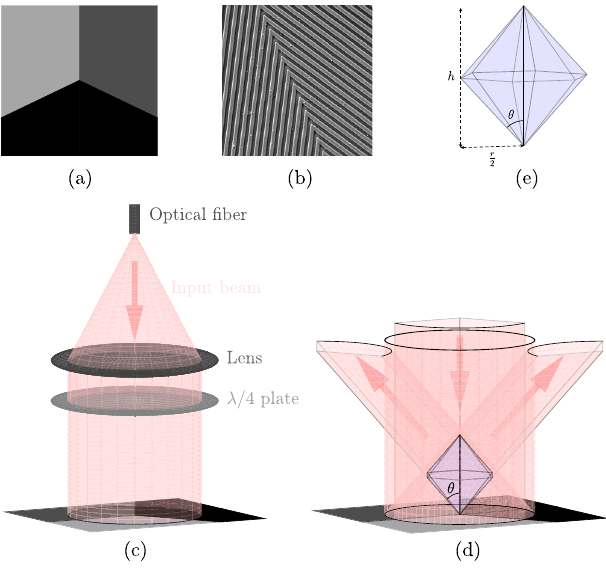
FIG. 1. Schematic representation of MOT production using an optical grating. (a) The grating chip consists of three identical linear gratings, lying in a plane with 120° relative orientations. (b) Scanning electron microscope (SEM) image showing the chip surface at a position where two gratings meet. (c) A single linearly polarized input beam emanating from an optical fiber is collimated and subsequently made circularly polarized. (d) The incoming and diffracted laser beams (red) together with the overlap volume (purple). (e) The overlap volume approximately has the shape of a double hexagonal pyramid and has a rms height h . The incoming laser beam has a rms radius r and is diffracted under an angle θ